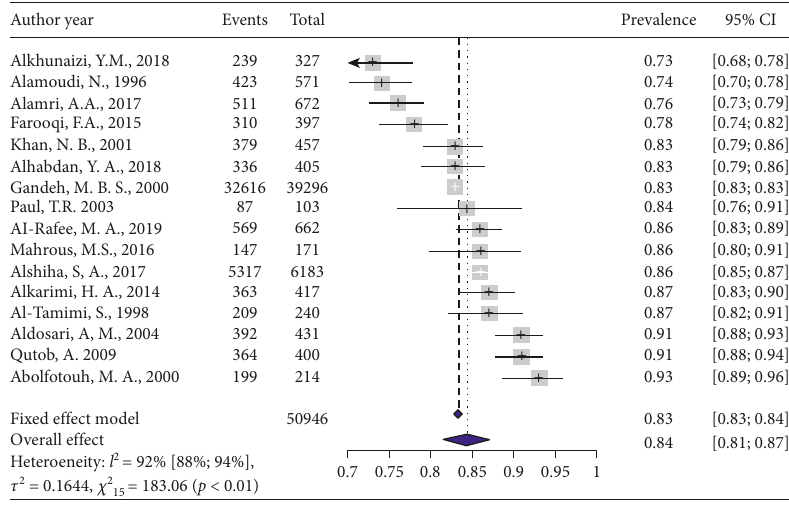
Figure 2: Pooled prevalence of dental caries among 5–7 -year